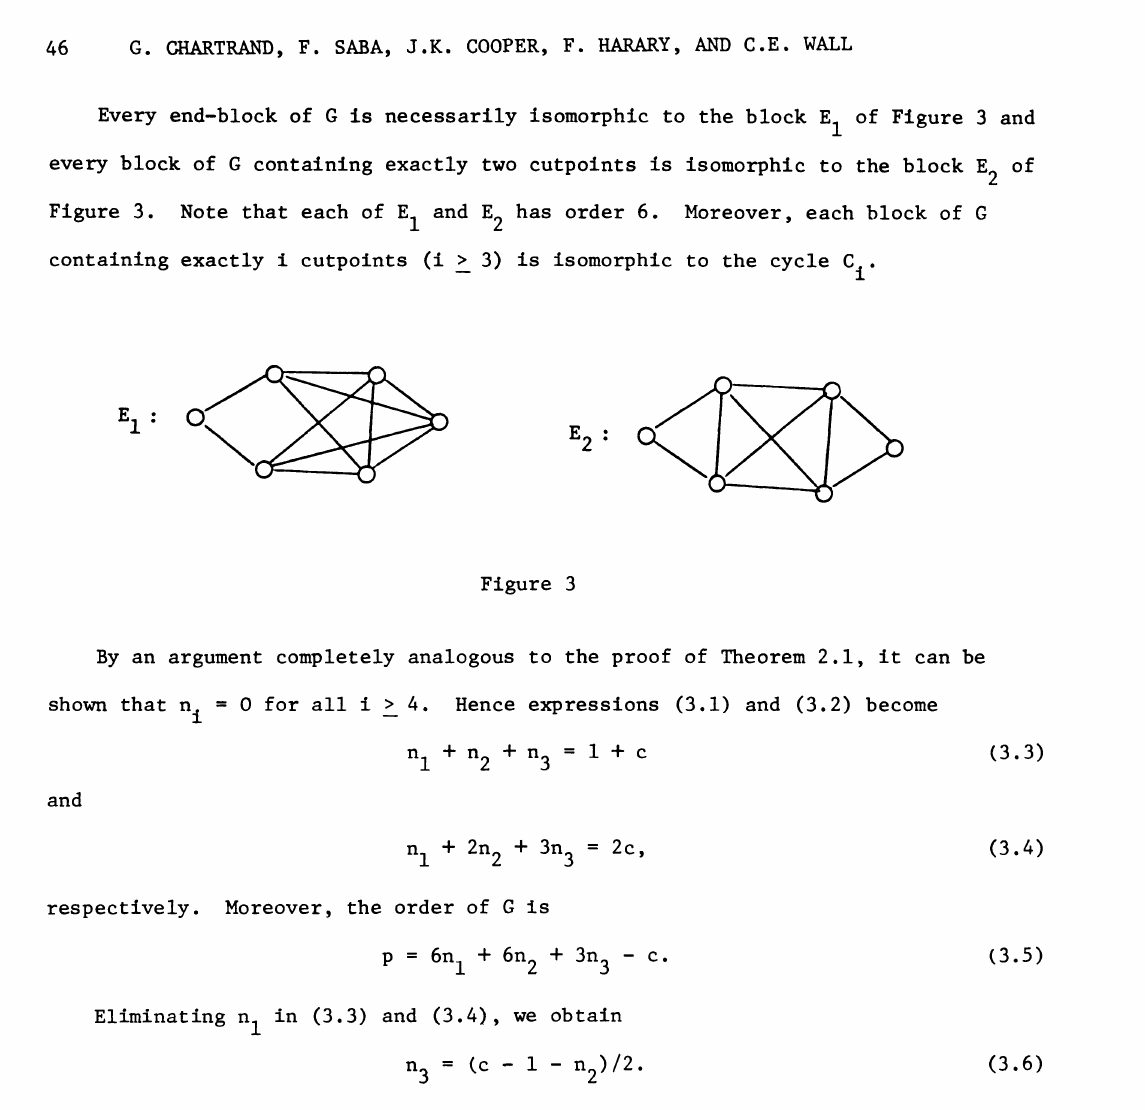
and E has order 6. Moreover, each block of G 1 2